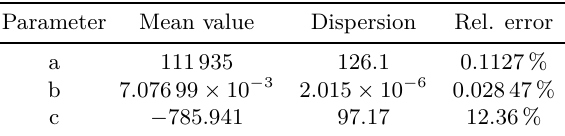
Table 1. Deviation between numerical and analytical solution.